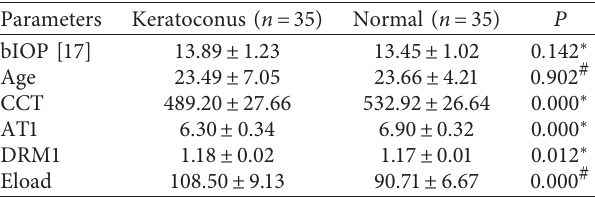
[17] IOP from Corvis ST was corrected based on finite element modeling. Pairwise matching was performed for bIOP. ∗ Two-tailed Student’s t -test. #Mann–Whitney U